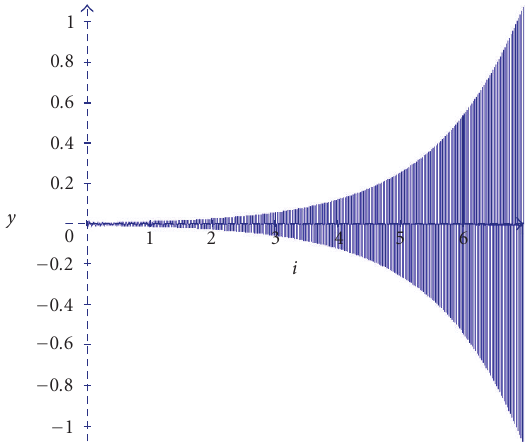
Figure 6.24 . Unstable solution of (5.1) in the point C (540,100), a 0 = 0 .